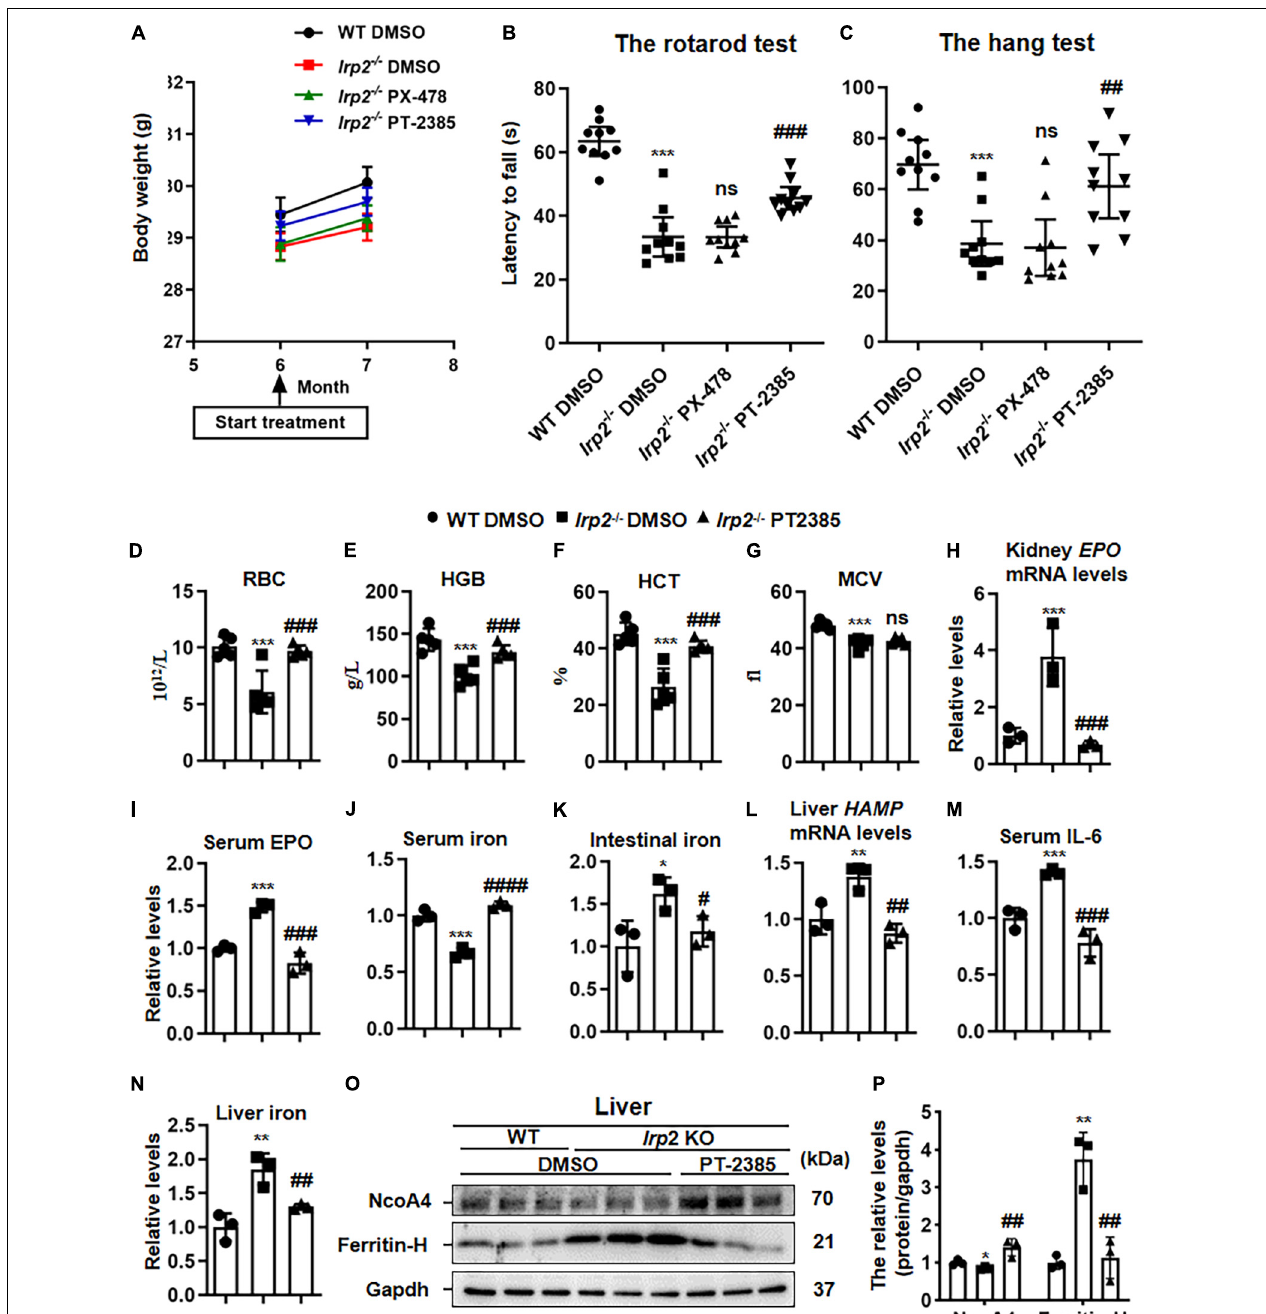
FIGURE 2 | The administration of Hif2 α inhibitor PT-2385, not Hif1 α inhibitor PX-478, improves the behavioral performance and corrects anemia of Irp2 − / − mice. Mice were divided into four groups: WT mice with vehicle [dimethylsulfoxide (DMSO)] administration (WT DMSO), Irp2 − / − mice with DMSO administration ( Irp2 − / − DMSO), Irp2 − / − mice with PT-2385 administration ( Irp2 − / − PT-2385, 0.4 mg/kg), and Irp2 − / − mice with PX-478 administration ( Irp2 − / − PX-478, 5 mg/kg). (A) The weight of mice before and after the drug administration. (B,C) The behavioral tests of mice, including the rotarod tests (B) and the hang tests (C) ; values are represented as the mean ± SD ( n = 10). (D) The number of the red blood cells (RBCs). (E) Hemoglobin concentration (HGB). (F) Hematocrit (HCT). (G) Mean corpuscular volume (MCV). (H) Erythropoietin ( EPO ) mRNA levels in the kidneys. (I) Serum EPO protein levels detected by enzyme-linked immunosorbent assay (ELISA). (J,K) Serum and intestinal iron content detected by the ferrozine iron assays. (L) HAMP mRNA levels in the livers. (M) Serum interleukin 6 (IL-6) protein levels detected by ELISA. (N) Liver iron content detected by the ferrozine iron assays. (O) Protein levels of NcoA4 and ferritin-H in the liver detected by western blot analysis. Gapdh was used as an internal control. (P) Quantification of the band intensity for panel (O) . From panels (D–P) , n = 3–5. The analysis of variance (ANOVA) was used for statistics to evaluate the group differences. In panels (B–N,P) , * P < 0.05, ** P < 0.01, *** P < 0.001, Irp2 − / − DMSO vs. WT DMSO; # P < 0.05, ## P < 0.01, ### P < 0.001, #### P < 0.0001, Irp2 − / − PT-2385 vs. Irp2 − / − DMSO; ns P > 0.05, Irp2 − / − PX-478 vs. Irp2 − / − and Irp2 − / − PT-2385 vs. Irp2 − / − DMSO.